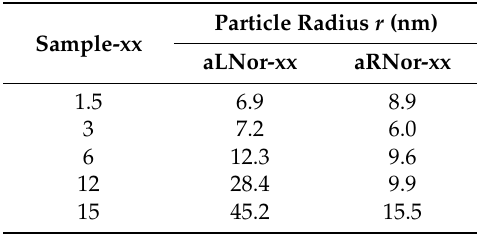
Table 7. Particle radii of aLNor-xx and aRNor-xx aerogels derived from N 2 -sorption and skeletal density data.